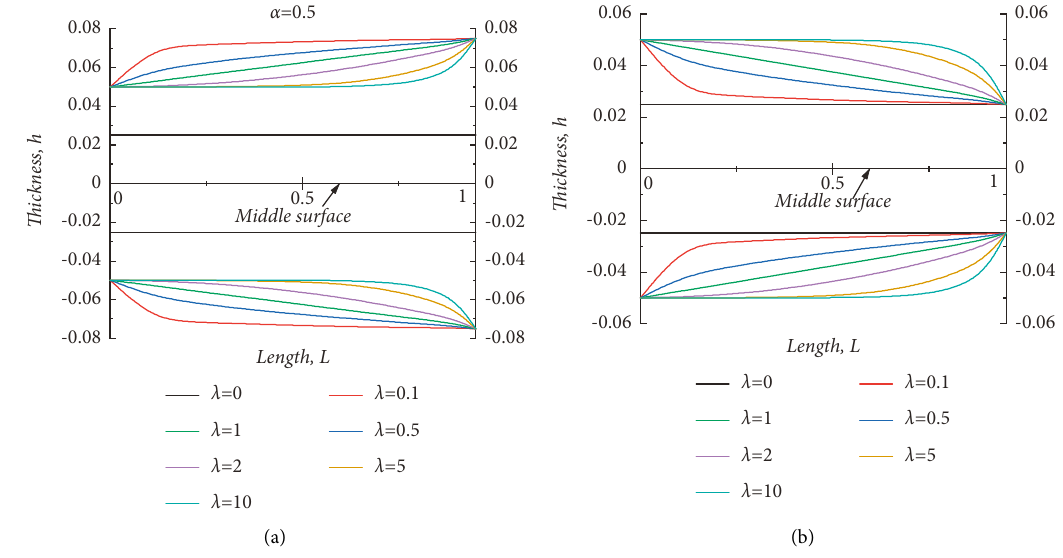
Figure 3: Change of thickness profile according to thickness variation parameter λ